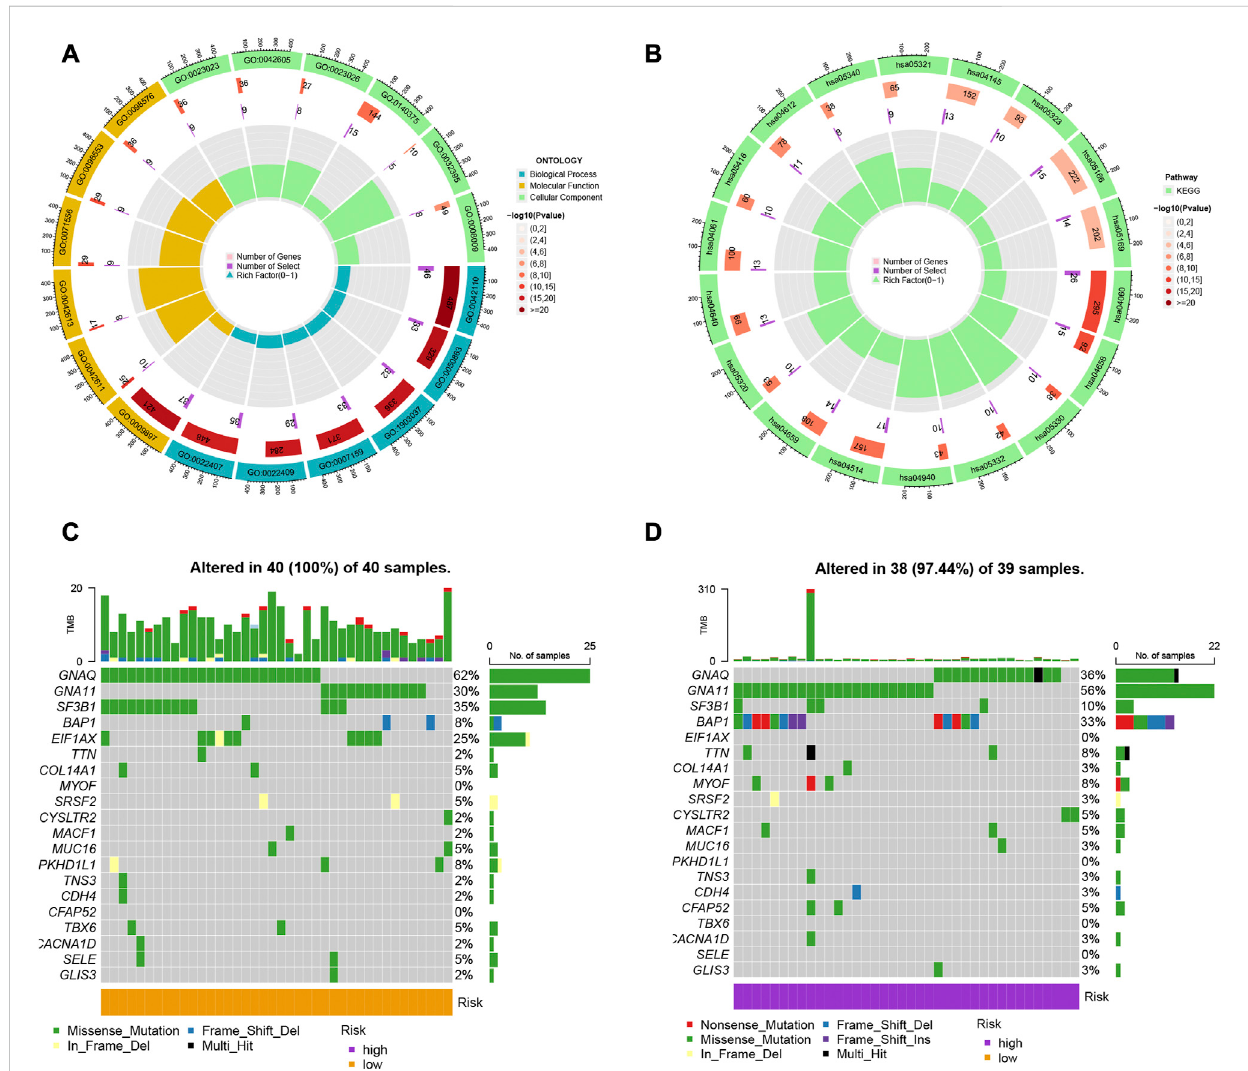
FIGURE 4 (A , B) GeneOntology(GO) andKyotoEncyclopediaofGenesandGenomes(KEGG)pathway analysesofthedifferentiallyexpressed genes(DEGs)in uveal melanoma. (C , D) Comparison of the prevalence and speci fi c altered genes of gene mutations across different risk